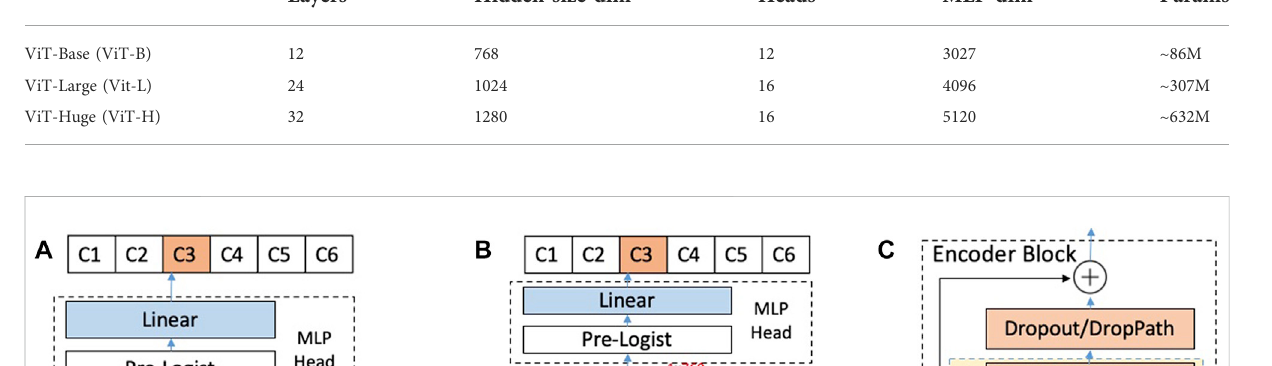
TABLE 2 Description and variations of ViT (Dosovitskiy et al., 2020) models. Layers